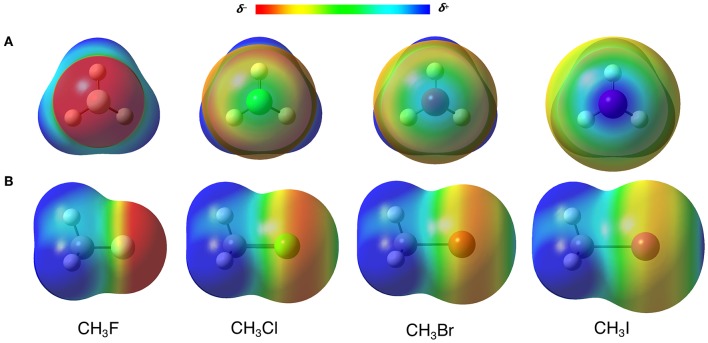
(A) Front and (B) side view of the electrostatic potential surfaces (at 0.02 a.u.) from −0.3 (red) to 0.3 (blue) a.u. of CH3X (X = F, Cl, Br, I) molecules. Computed at B3LYP-D3(BJ)/def2-TZVP, using Gaussian 09 (Frisch et al., 2009).